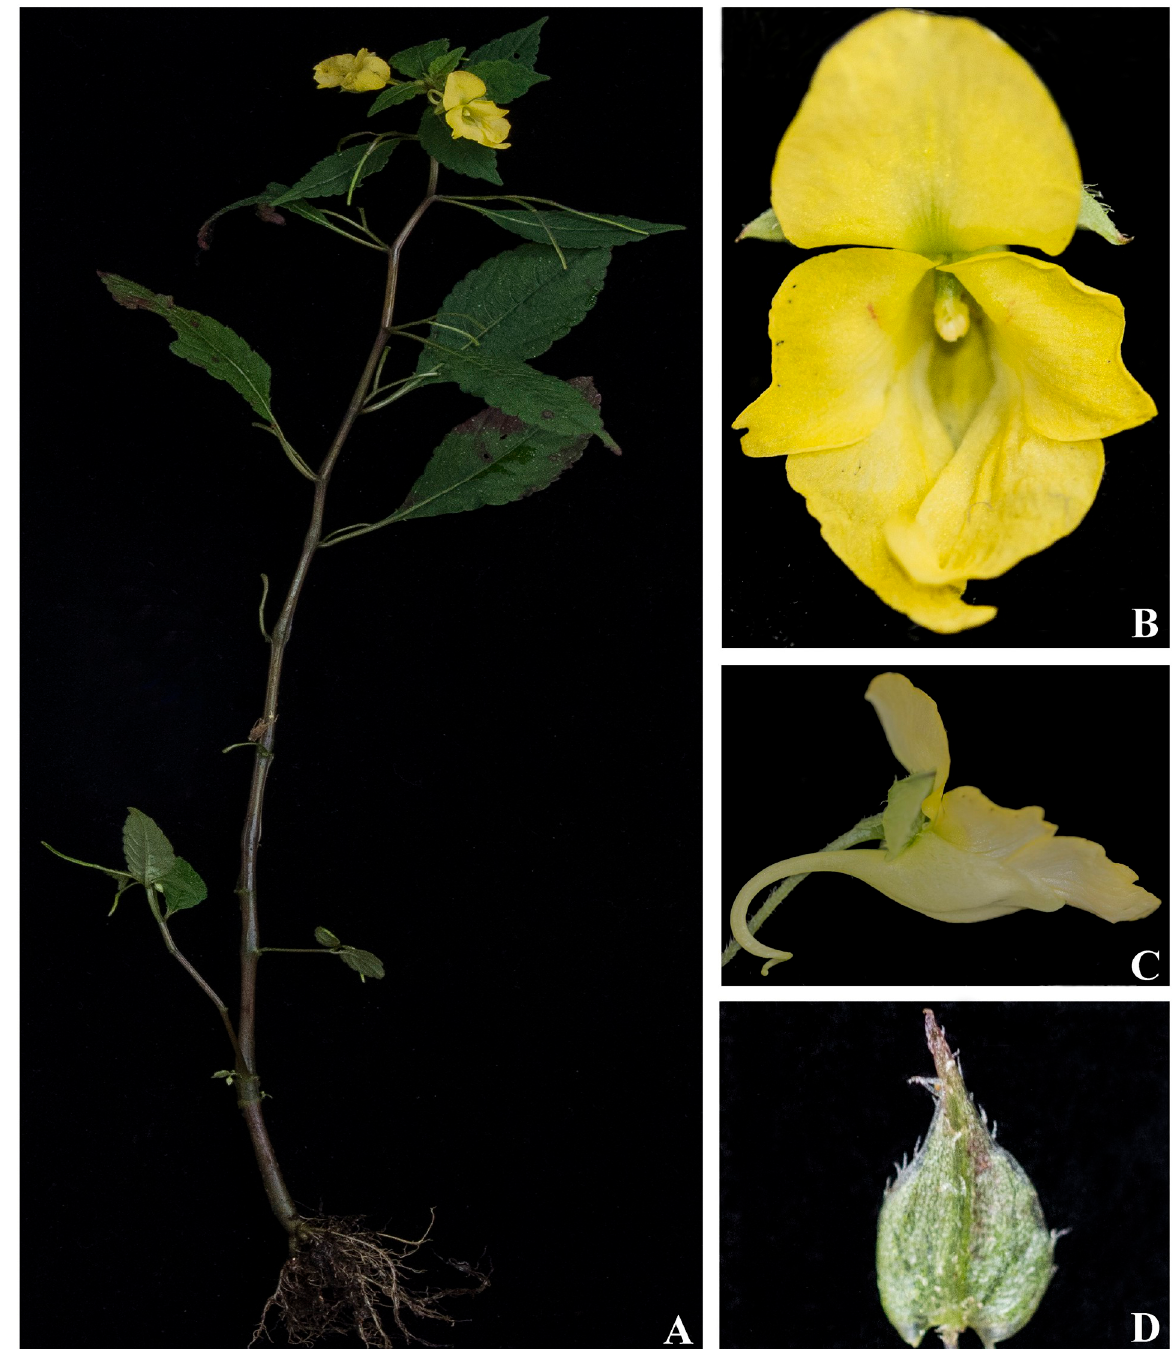
Fig 27. Impatiens sikkimensis A. Flowering plant; B. Flower (Front view); C. Flower (side view). Photographs by Bhakta Bahadur